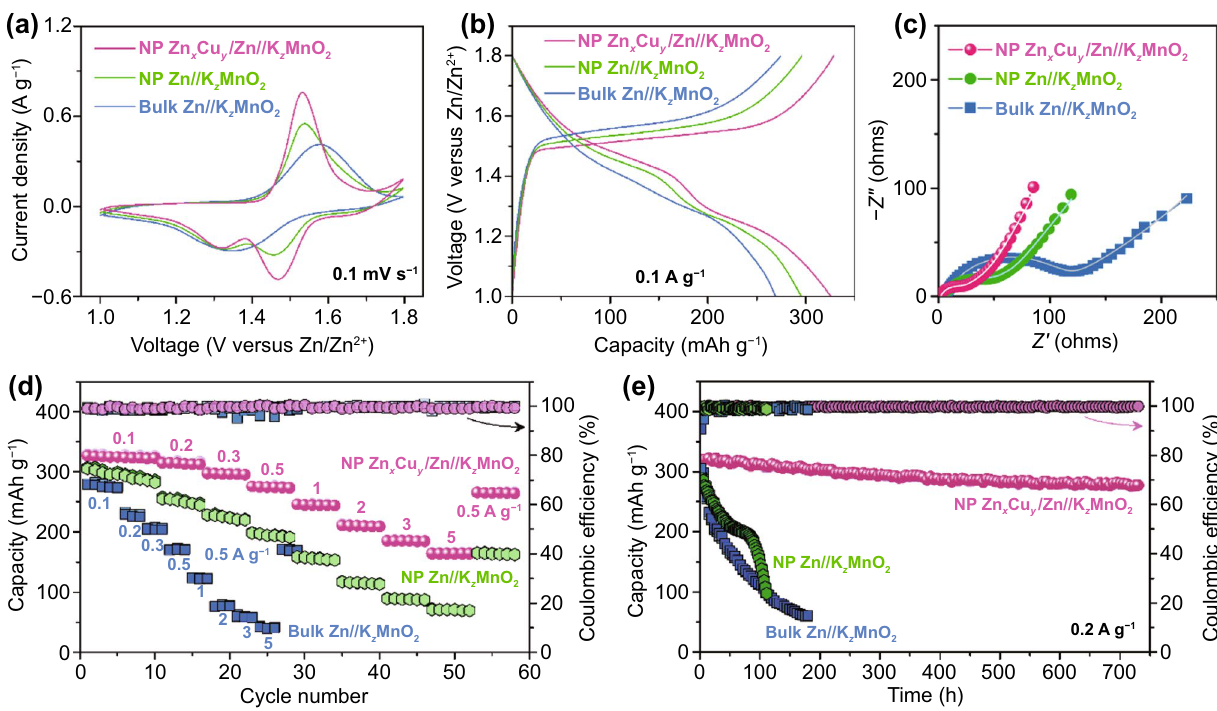
Fig. 4 Electrochemical performance of full Zn‑ion cells. a Representative CV curves of full cells of nanoporous Zn x Cu y /Zn//K z MnO 2 , nano‑ porous Zn//K z MnO 2 and bulk Zn//K z MnO 2 . Scan rate: 0.1 mV s ‒ 1 . b Representative charge/discharge voltage profiles of nanoporous Zn x Cu y / Zn//K z MnO 2 , nanoporous Zn//K z MnO 2 and bulk Zn//K z MnO 2 full cells at the specific current of 0.1 A g ‒ 1 (based on the loading mass of elec‑ troactive K z MnO 2 at the cathode). c EIS spectra of nanoporous Zn x Cu y /Zn//K z MnO 2 , nanoporous Zn//K z MnO 2 and bulk Zn//K z MnO 2 full cells. d Comparisons of rate performance and coulombic efficiency for nanoporous Zn x Cu y /Zn//K z MnO 2 , nanoporous Zn//K z MnO 2 and bulk Zn// K z MnO 2 full cells, where are performed at various specific currents from 0.1 to 5 A g ‒ 1 . e Capacity retentions and coulombic efficiencies of nanoporous Zn x Cu y /Zn//K z MnO 2 , nanoporous Zn//K z MnO 2 and bulk Zn//K z MnO 2 full cells in a long‑term charge/discharge cycling measure‑ ments at the specific current of 0.2 A g ‒